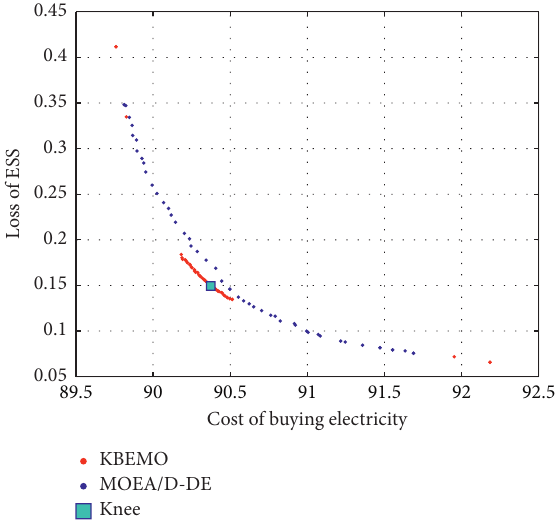
Figure 6: Pareto fronts obtained by MOEA/D-DE and